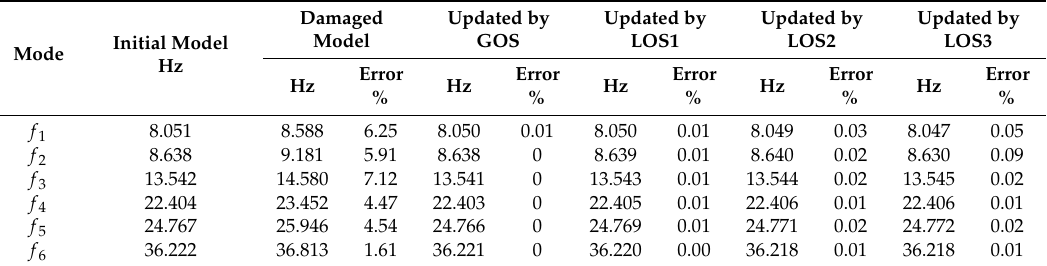
Table 8. The error of frequency between updated model and damaged